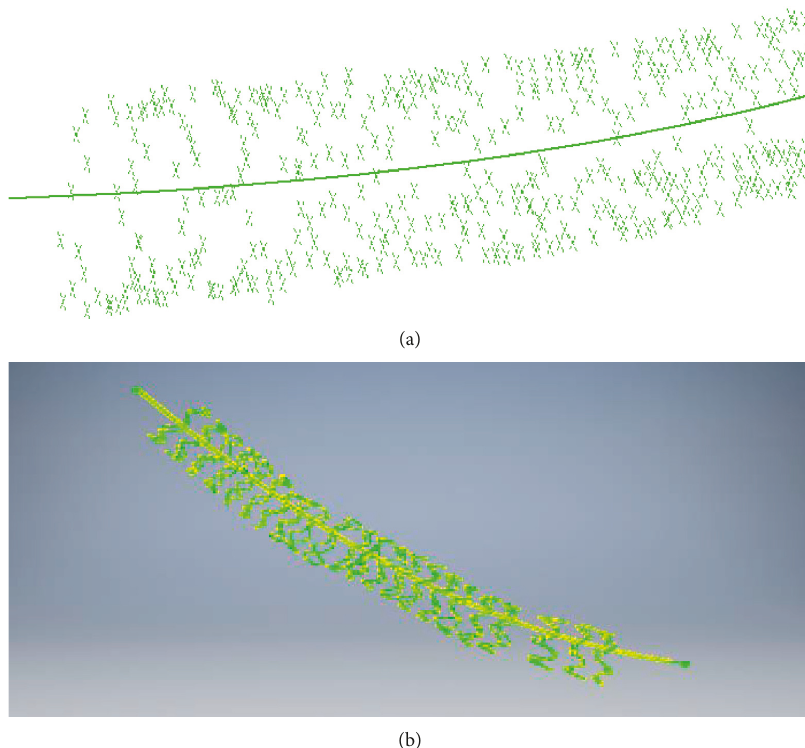
Figure 4: (a) Biodegradable scaffold point cloud extraction. (b) Three-dimensional model reconstruction.